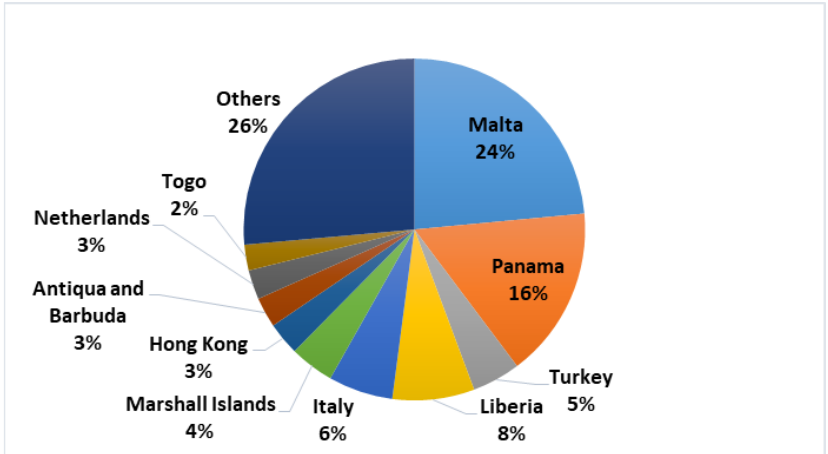
Figure A6. Percentages of BW discharged in the Port of Ploče by ship age.